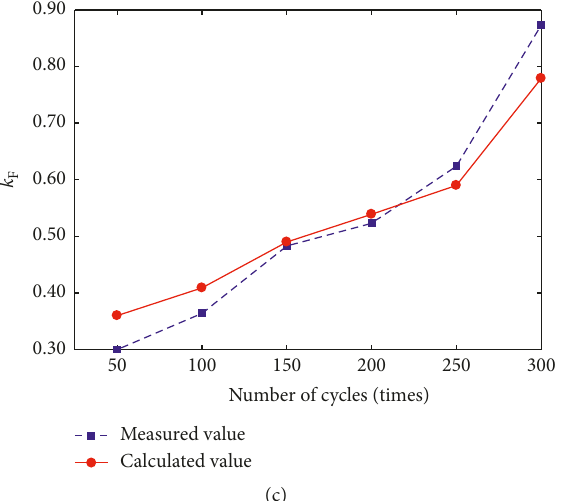
Figure 9: Comparison of measured value and calculated value of composite damage coefficient k (c)